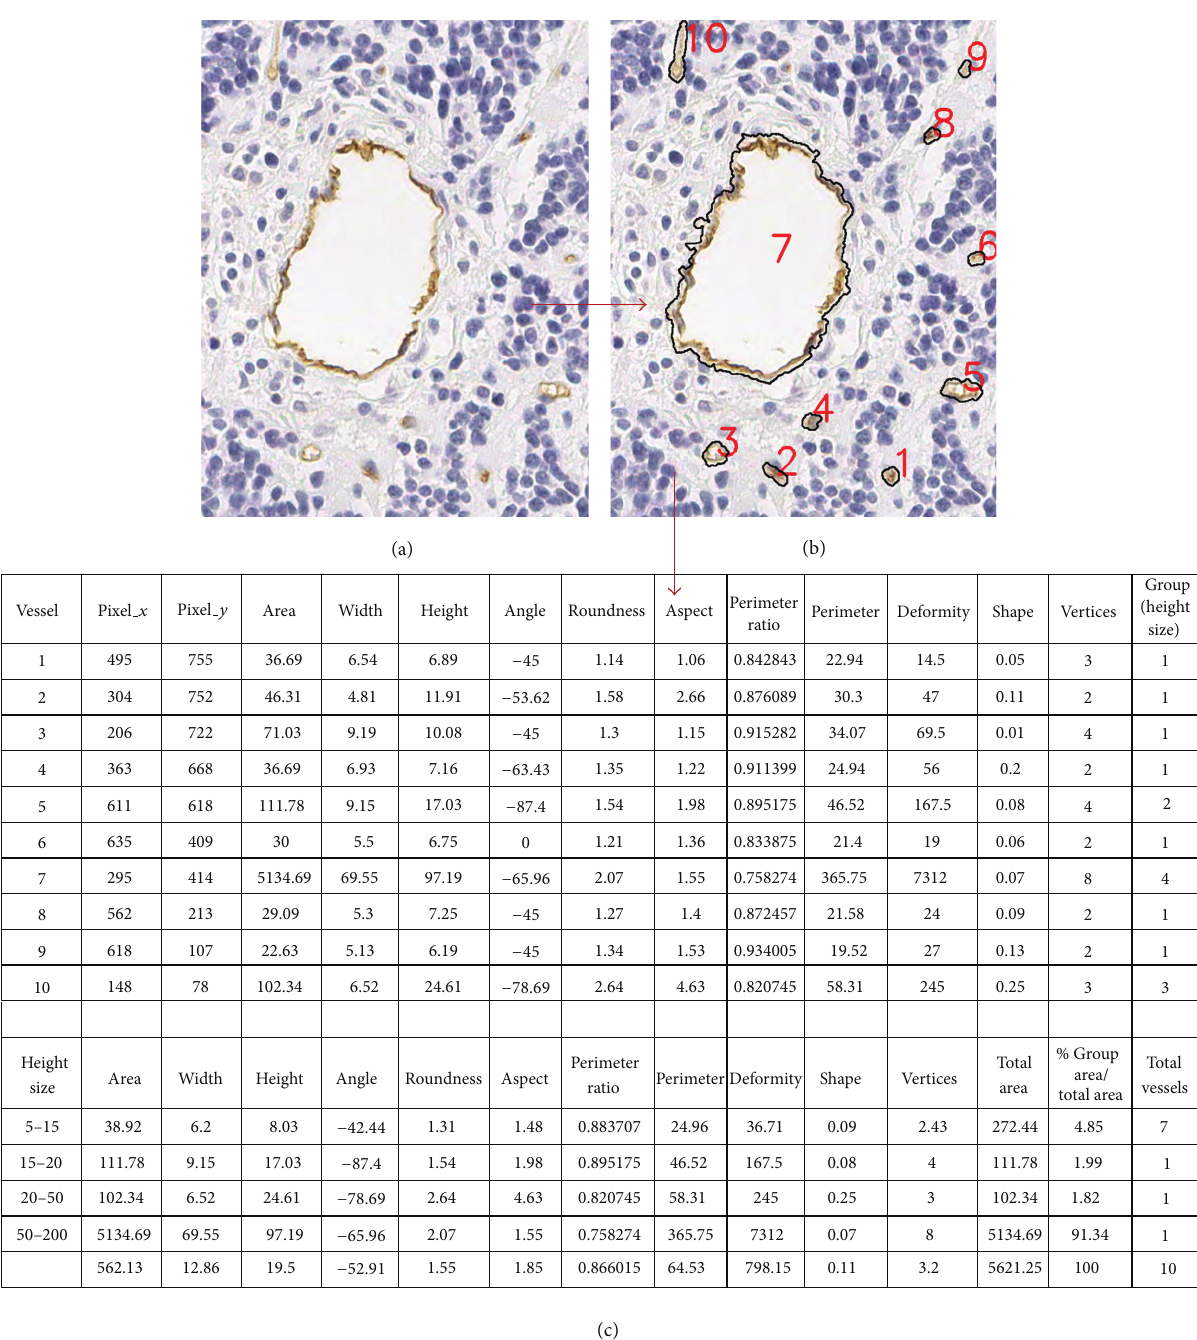
Our method takes between 10 and 180 seconds for images with 2 and 600 vessels, respectively. The algorithm accepts images of any size. The average image size of our dataset is 6300 × 6300 pixels, that is, 120 MB. CAIMAN takes an aver- age of 230 seconds for a 1.5 MB image, that is, about 1200 × 960 pixels. CAIMAN could not handle the image size of our dataset since the maximum size allowed is 2